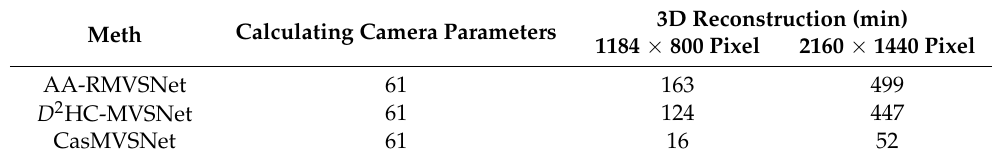
Table 2. Time consumption of various methods. Meth